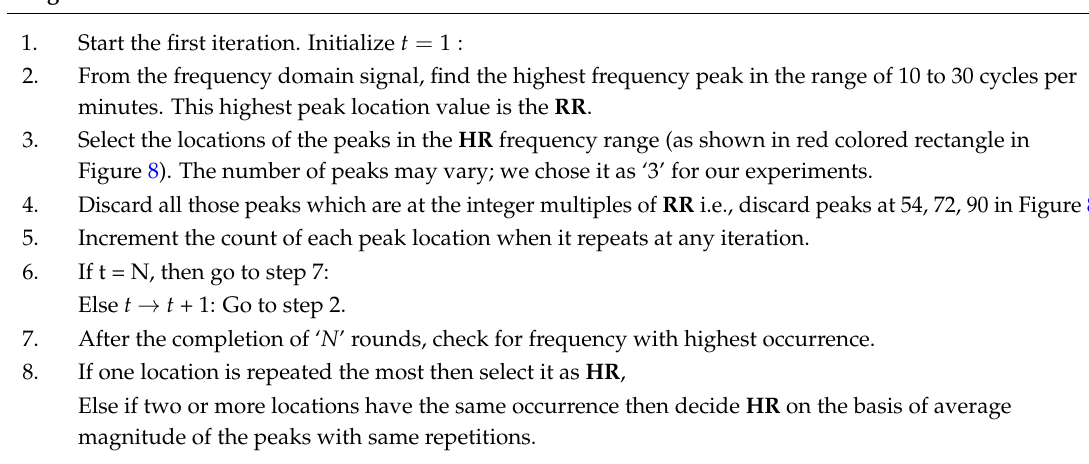
Algorithm 1: Selection of the Heart